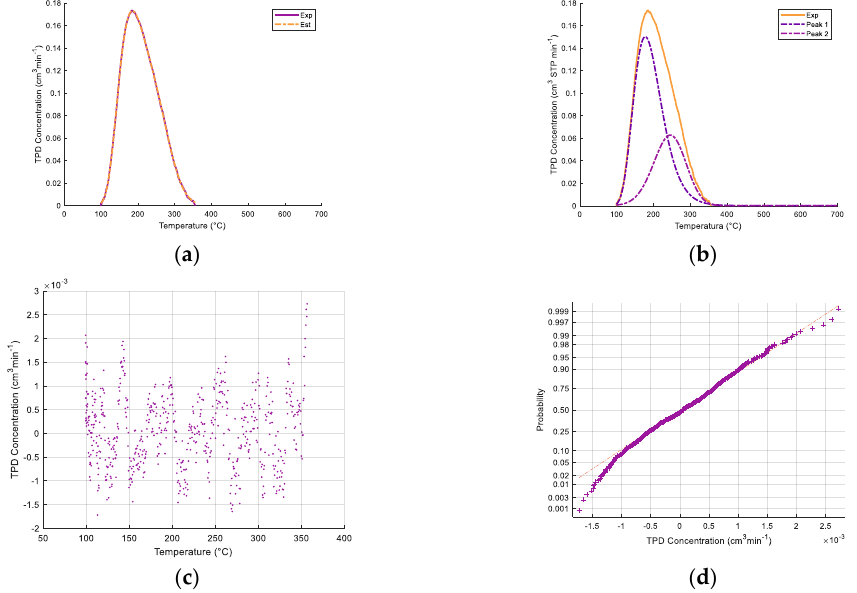
Figure A1 . Deconvolution of the NH 3 -TPD curve for 5% CaO/ γ-Al 2 O 3. ( a ) Adjustment curve with R 2 = 1.00, ( b ) composition curves, ( c ) regression residues, ( d ) Probability distribution of the adjustment curve selected.